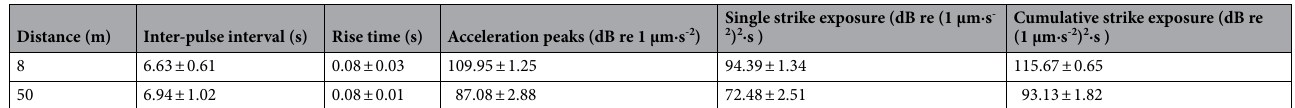
Table 1. Substrate-borne vibrations’ features from the impact hammer recorded during PD with the geophone at 8 and 50 m calculated on 536 and 315 strikes, corresponding to two days of experiments. Cumulative strive exposure levels at 8 and 50 m were calculated from, on average, 115 and 129 strikes, respectively. Values represent mean ± standard deviation.